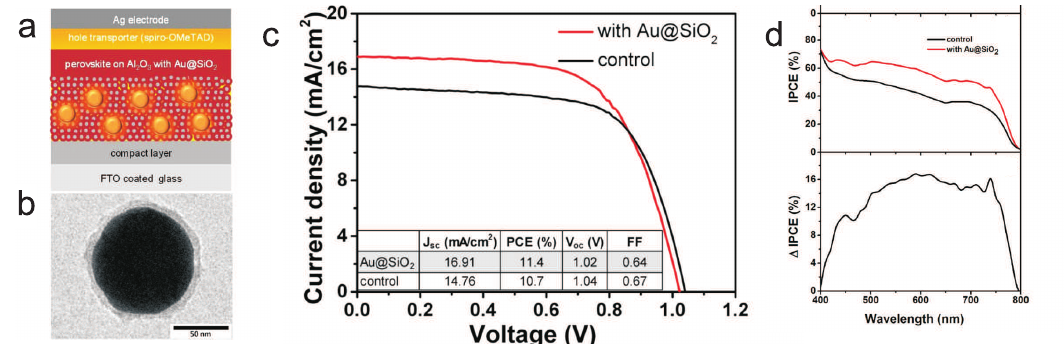
Figure 6. ( a ) illustration of device structure with the component-layers indicated ( b ) TEM image [13] of Au/SiO 2 core–shell NP ( b 40 nm, a 48 nm—cf. Figure 1); ( c ) I–V curve for perovskite ∼ ∼ cell with porous Al 2 O 3 basis filled with Au/SiO 2 core–shell nanoparticles with density 1 wt %; ∼ a strong increase of the photo-current is noticeable with simultaneous lowering of the voltage; ( d ) IPCE (photon-to-current conversion efficiency) spectra of control and with Au/SiO2 devices and its increase ( ∆ IPCE) due to the addition of Au/SiO 2 NPs (devices measured under AM1.5 simulated sunlight, 100 mW/cm 2 irradiance). After experiment [13].